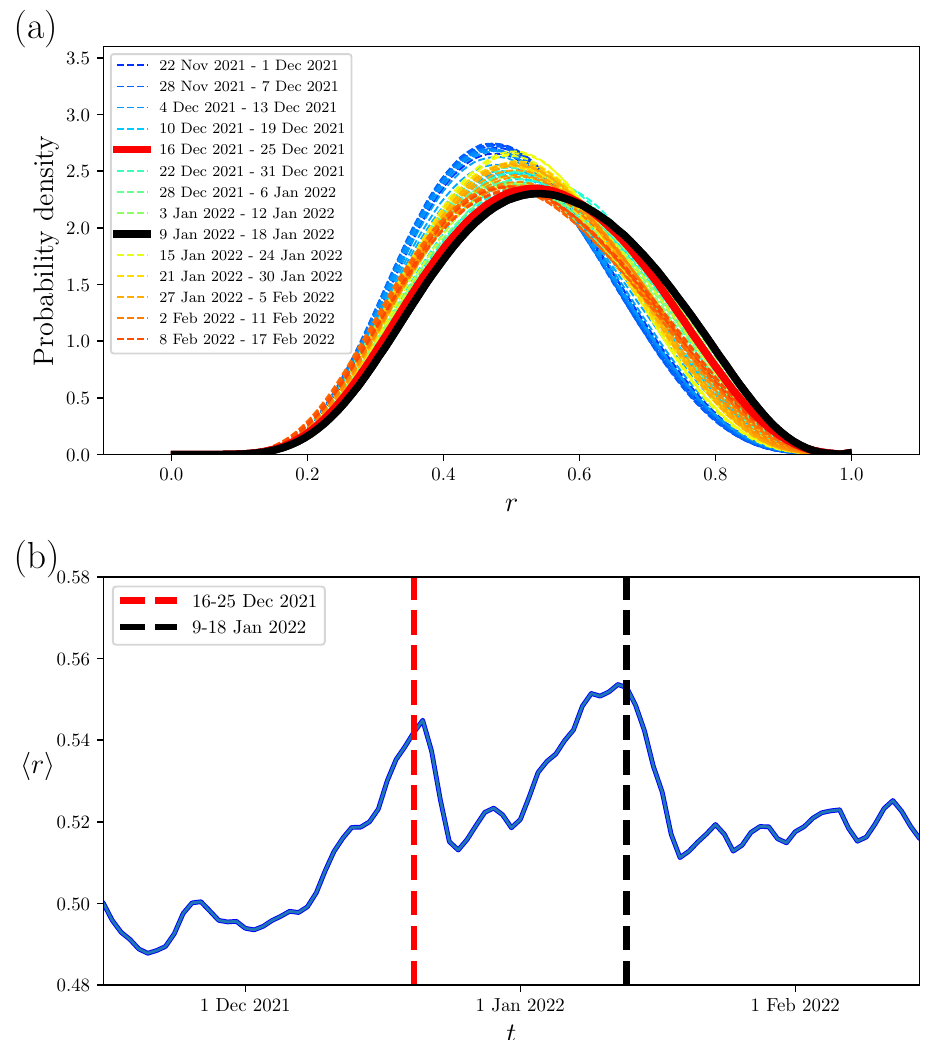
Figure 3. ( a ) The probability density distribution function of link strength r for all climate networks (with different periods). The distribution for the dominant eruptions of the HTHH are remarked by red and black solid lines, respectively. The distribution for the other periods are shown in dashed r lines. ( b ) The average link strength as a function of time is presented by the blue line. Here, the (cid:104) (cid:105) start dates of the two dominant eruptions correspond to the middle day of the two